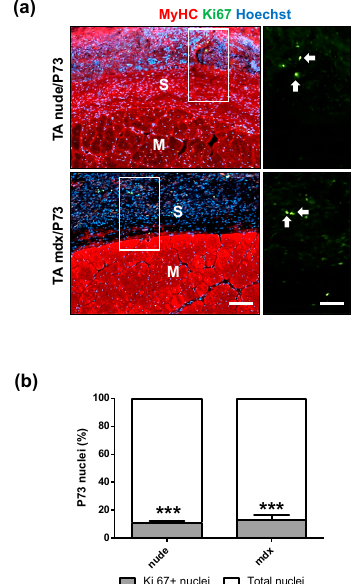
Figure 7. Ki67 positive cells populating P73-implanted scaffold. ( a ) Ki67 staining in P73-implanted tibialis anterior (TA) muscles from nude and mdx mice. ( b ) Quantitative analysis of Ki67 positive cells (green) reveals that only ~10% of total cells colonisingP73 scaffold from both nude and mdx implanted muscles are Ki67 positive (nude mice n = 3, mdx mice n = 3). Magnification areas (upper right and lower right panels) from rectangles show Ki67 positive nuclei (white arrows). MyHC signal is in red while nuclei are stained in blue with Hoechst. *** p < 0.001 vs. total nuclei. Scale bars: lower left panel = 100 µm; lower right panel = 25 µm.